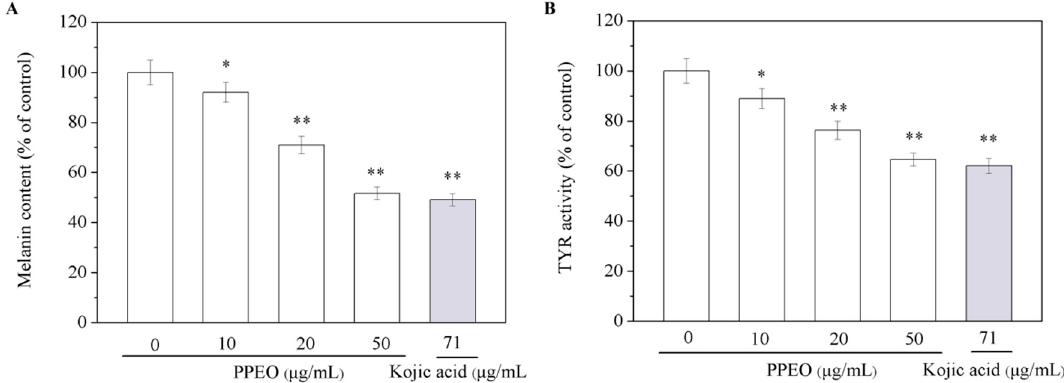
Figure 5. Effect of PPEO on melanin content ( A ) and tyrosinase activity ( B ) in B16 cells. * Indicates samples that are significantly different ( n = 3; * p < 0.05 and ** p < 0.01 compared with the blank control group).